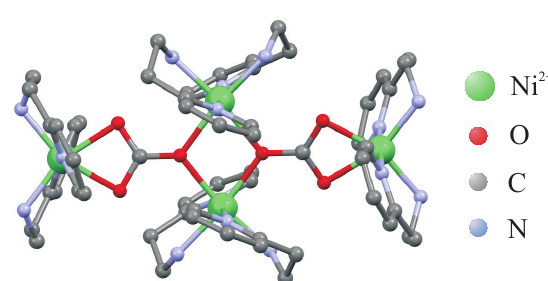
Figure 7. A crystal structure of the tetranuclear nickel complex [Ni 4 ( µ -CO 3 ) 2 (aetpy) 8 ](ClO 4 ) 4 (aetpy = 2-aminoethyl-pyridine) abbreviated as {Ni 4 } with a magnetic structure of ’butterfly tetramer’, which is visualized according to crystallographic data reported in Ref. [63]. Crystallographic positions of hydrogen atoms and perchlorate anions ClO − were omitted for better clarity. 4